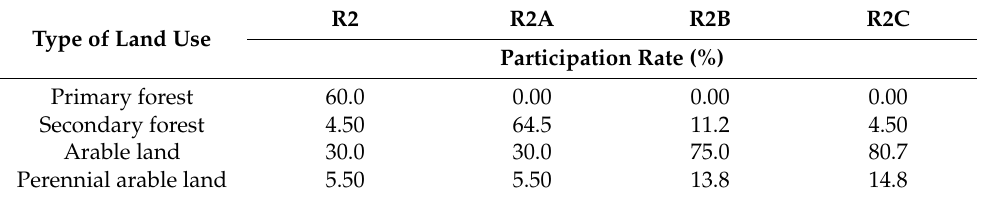
Table 6. Alternative scenarios for expanding soy cultivation compared to other types of land use. R2 R2A R2B R2C Type of Land Use Participation Rate (%) Primary forest 60.0 0.00 0.00 0.00 Secondary forest 4.50 Arable